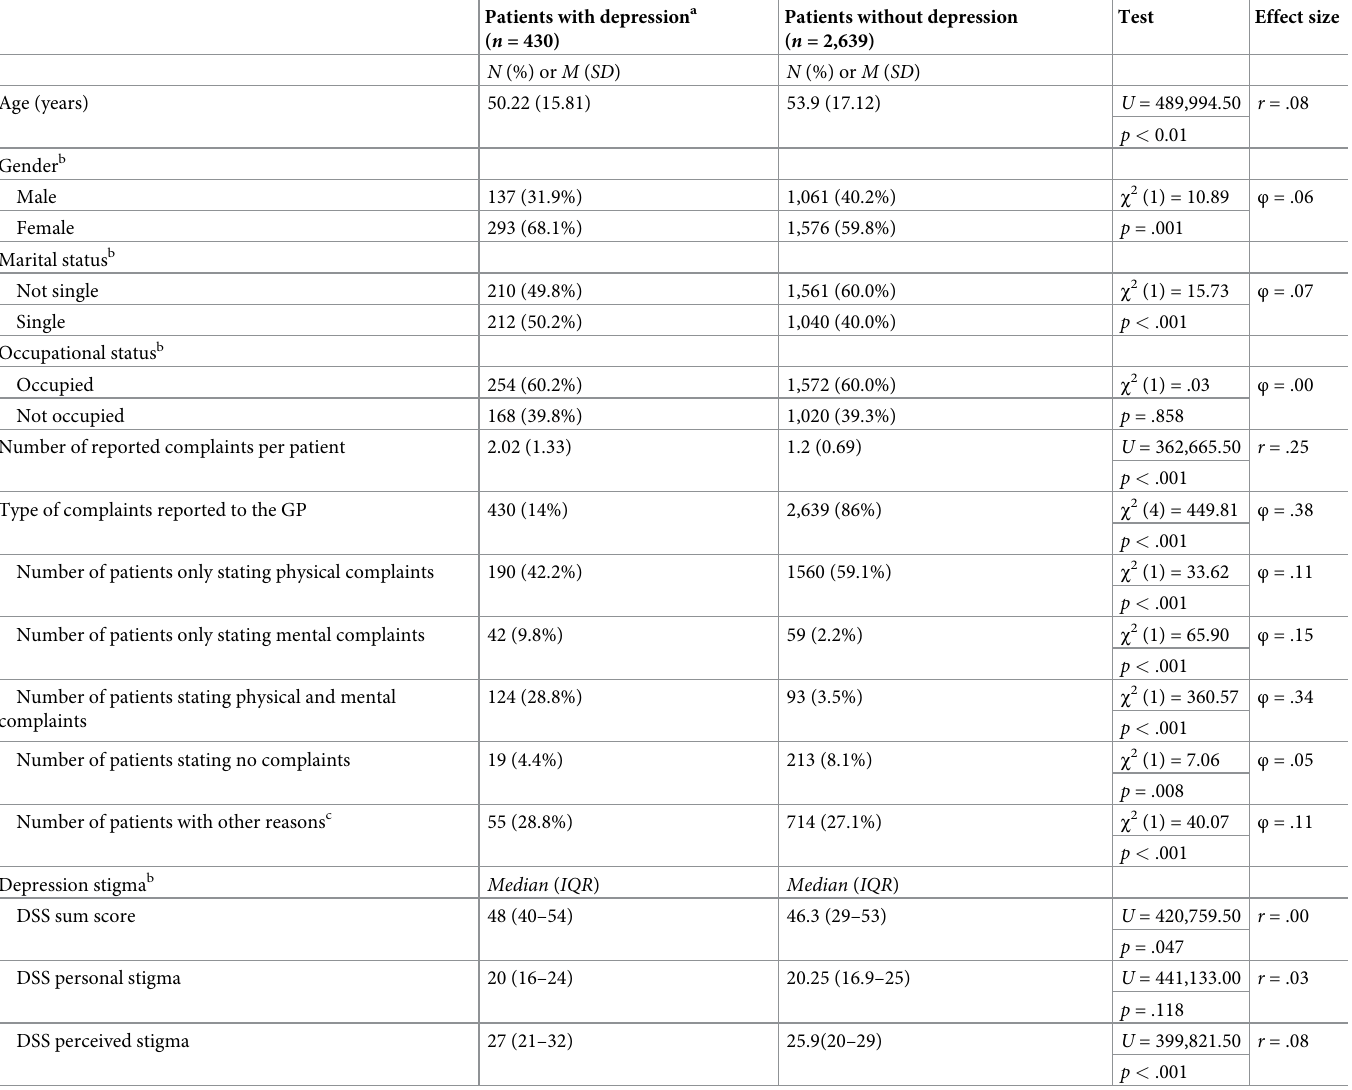
Table 1. Sociodemographic characteristics, depression stigma and complaints reported to the GP in patients with and without depression.